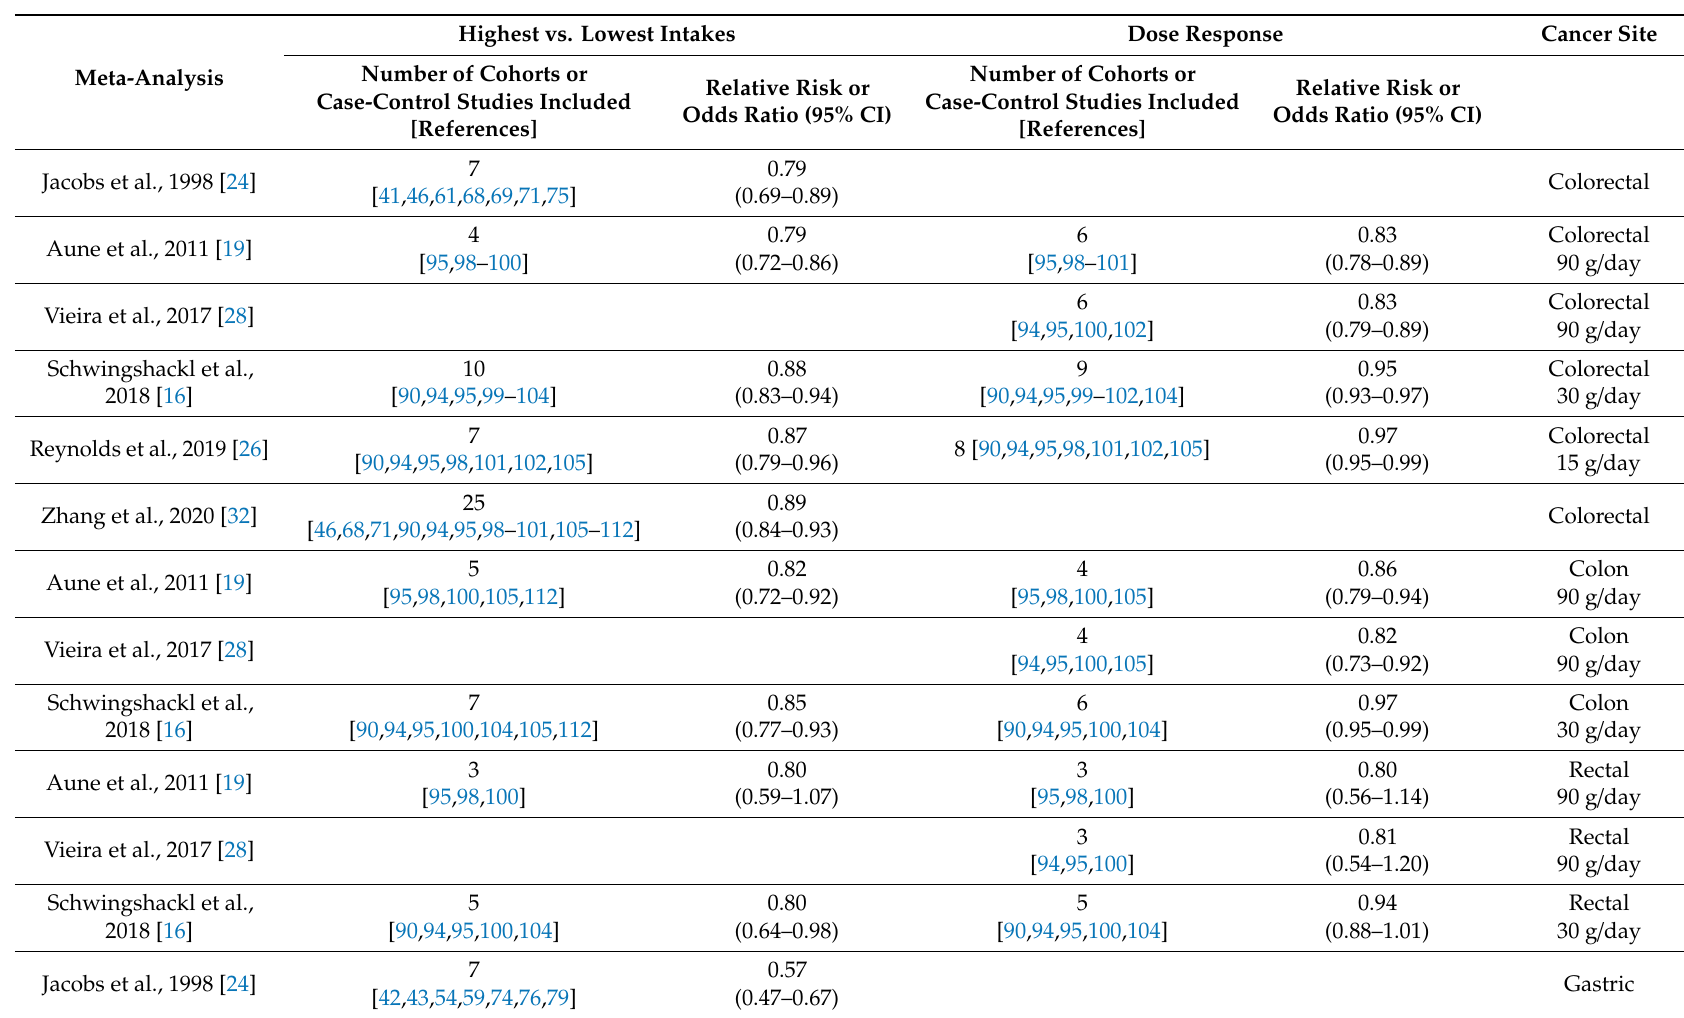
Table 2. Whole grain intake and risk of site-specific cancer: Results from meta-analyses of observational cohort and case-control